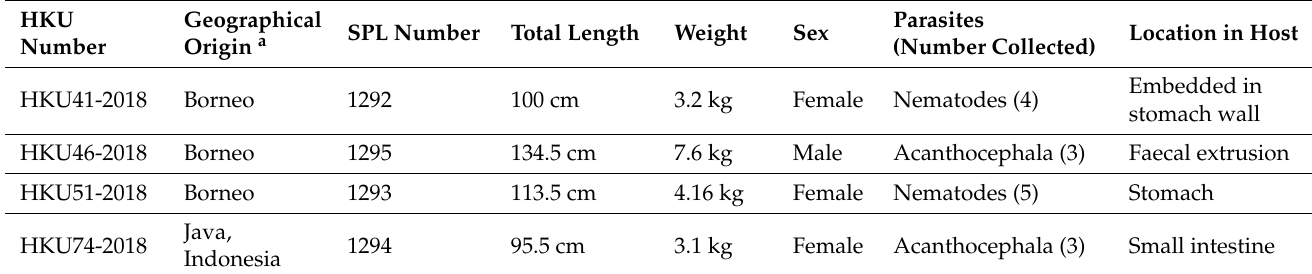
Table 1. Host information. AFCD case reference number for all pangolins: CPM/4/55/18. HKU, Hong Kong University; SPL, Shamsi Parasitology